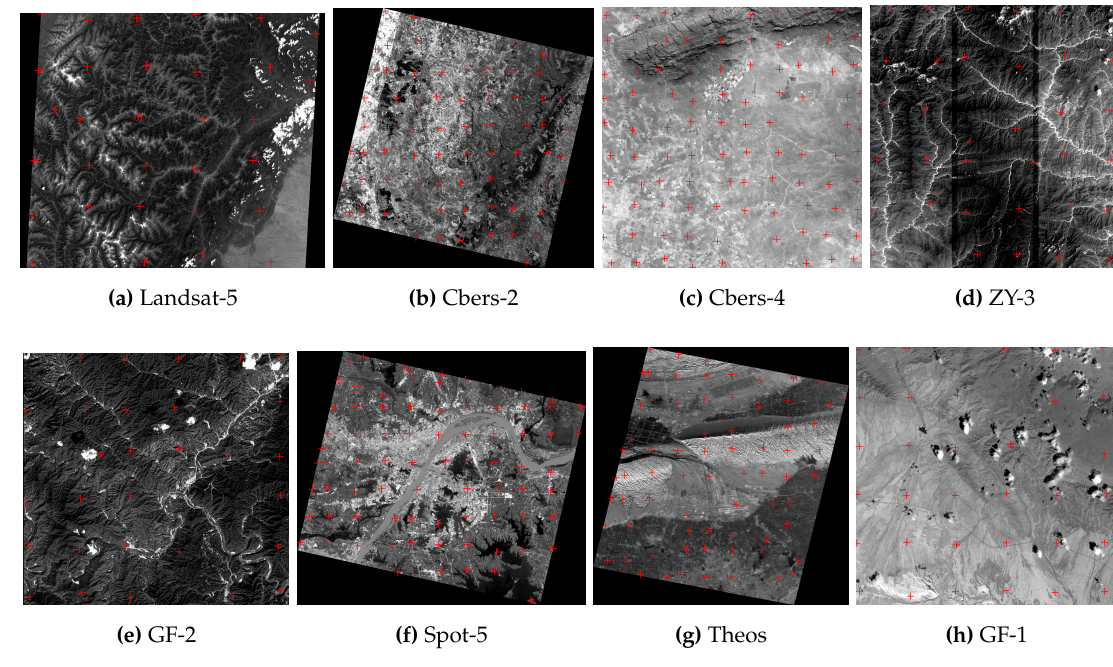
Figure 10. Distribution of matched points (marked by a cross) and sensed images in online image matching tests. ( a – h ) are the results of Landsat-5, Cbers-2, Cbers-4, ZY-3, GF-2, Spot-5, Theos and GF-1 images,